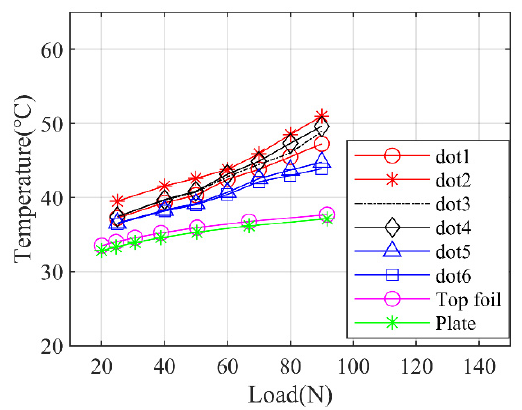
Figure 20. Relationship between bearing top foil temperature and load.